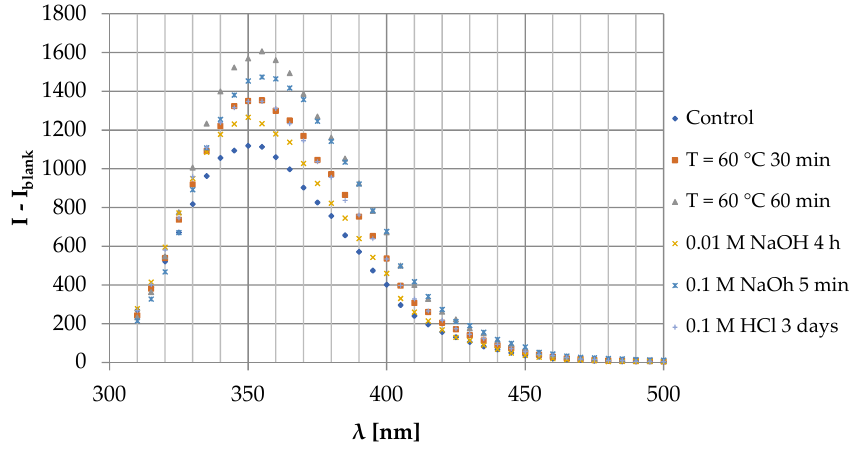
Figure A12. Emission spectra of various Lf stress samples compared to Lf control sample (FLD